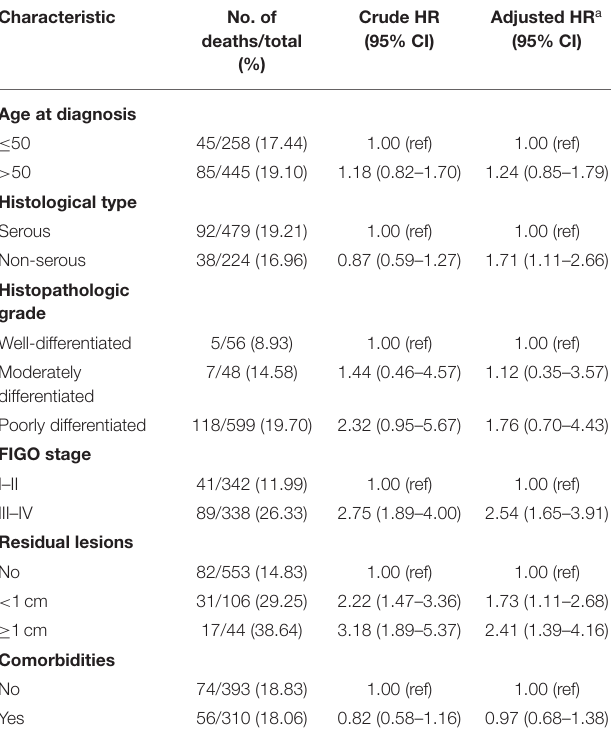
TABLE 2 | Selected clinical characteristics and associations with all-cause mortality among women diagnosed with ovarian cancer ( N = 703). Characteristic